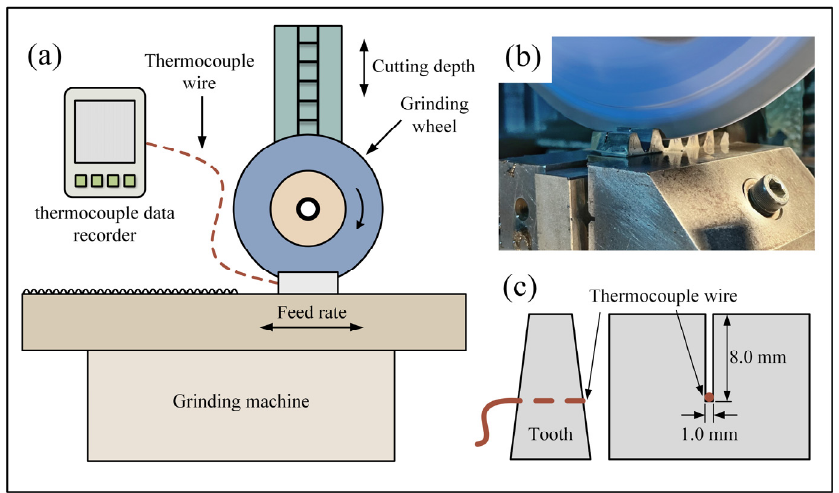
Figure 2. ( a ) Experiment setup, ( b ) grinding process and ( c ) installation of thermocouple.